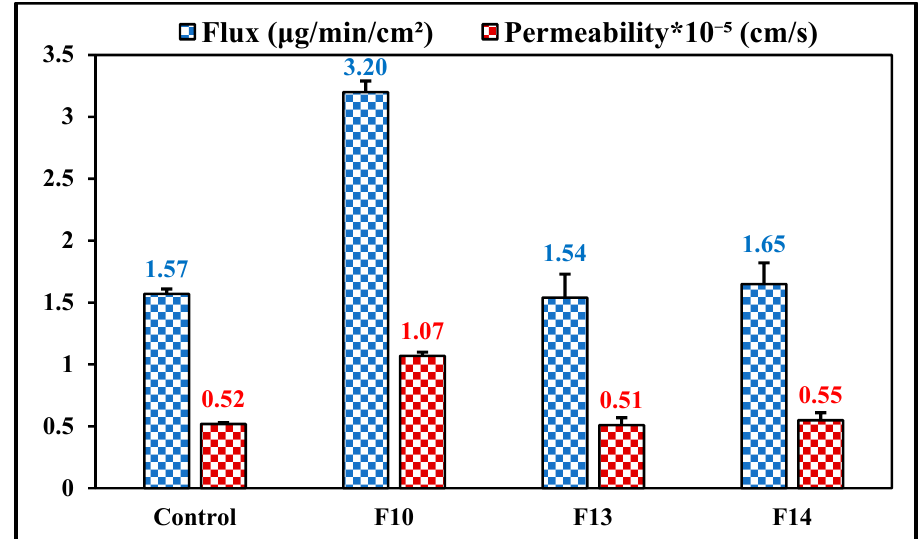
Figure 4. Transcorneal flux and permeability of moxifloxacin from F10, F13 (HPMC K4M), F14 (PVP K29/32), and control (Vigamox ® ) formulations through isolated rabbit corneas (mean ± SD, n = 3).